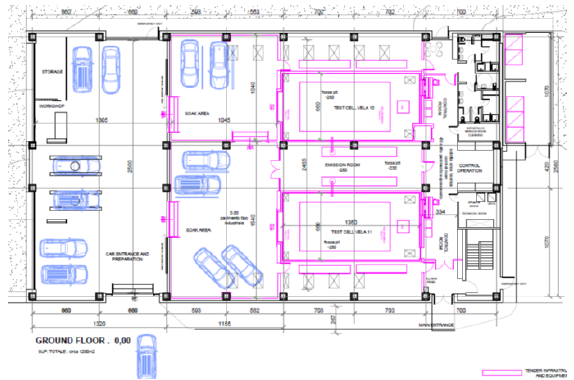
Fig. 5. New Vehicle Emissions Laboratories (VELA 10 and VELA 11) building plan [5]